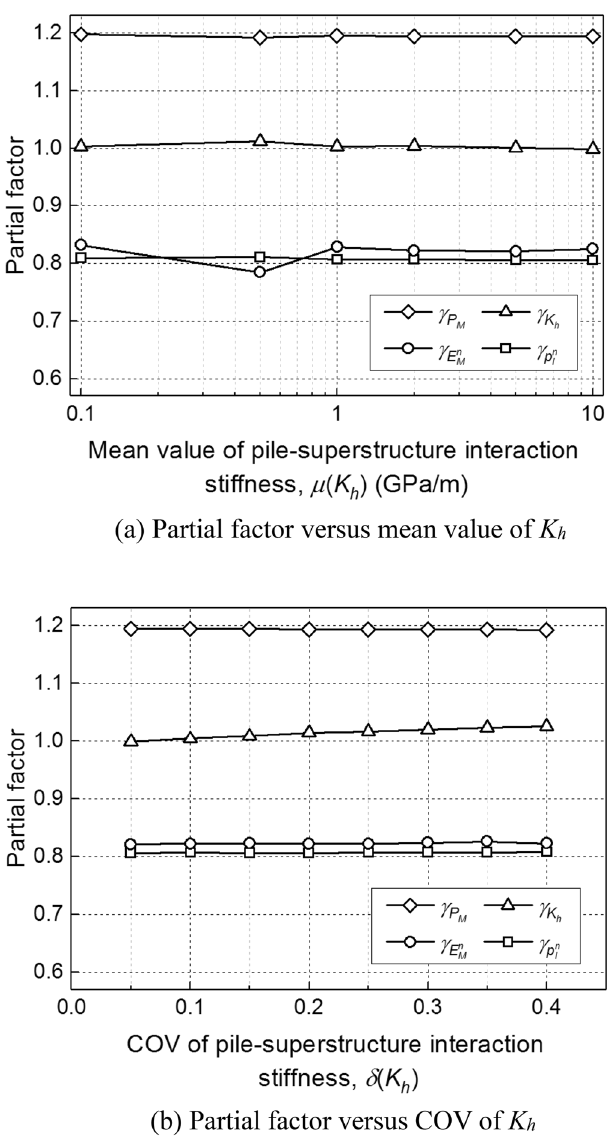
Figure 8. Effect of pile-superstructure interaction stiffness ( K h ) on calibrated partial